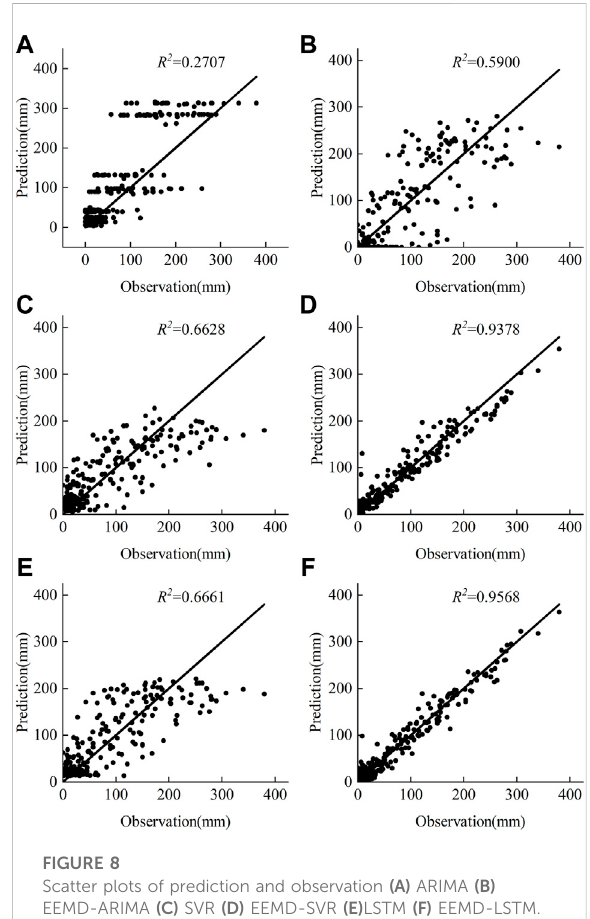
FIGURE 8 Scatter plots of prediction and observation (A) ARIMA (B)